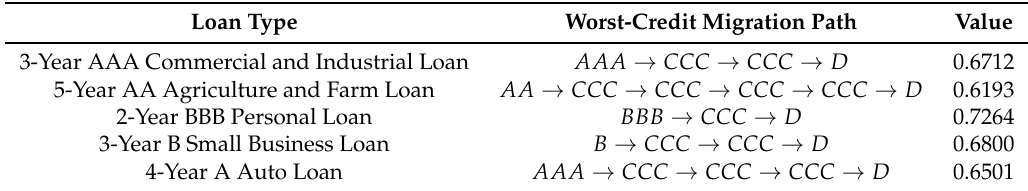
Table 5. Year-ahead or forward market value of loans under default.